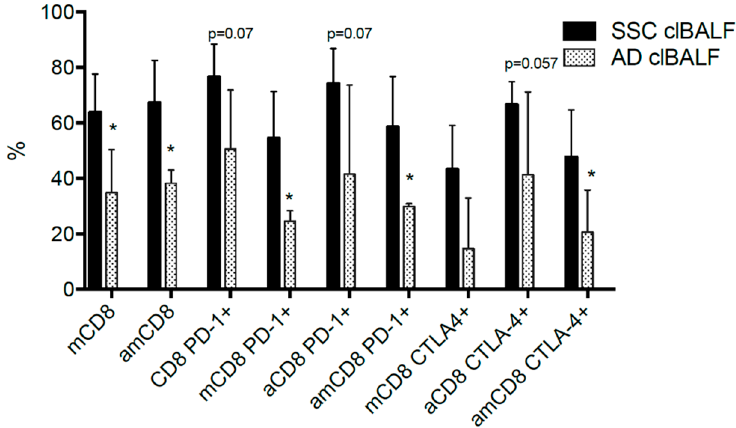
Figure 3. Significant differences in the proportion of clBALF cells with the expression of PD-1 and CTLA-4 between squamous cell carcinoma (SSC) and adenocarcinoma (AD) (* p < 0.05, exceptions were shown). Abbreviations: n—naïve, m—memory, a—activated, and am—activated memory cells.